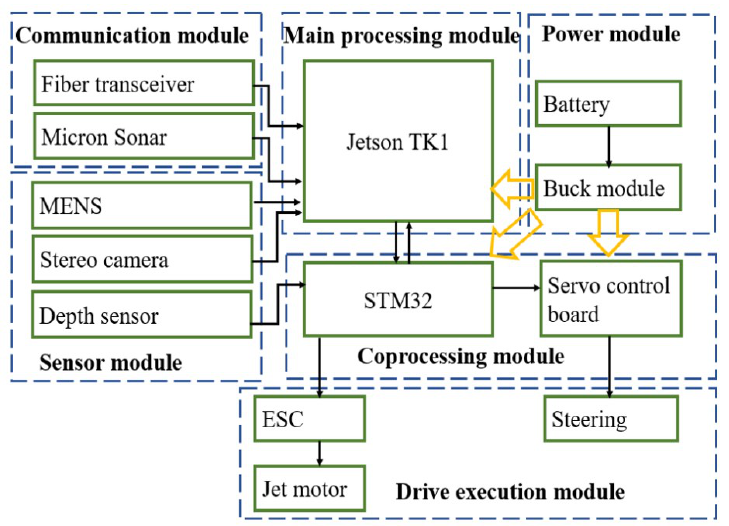
Figure 2. Electrical devices and modules of the new-generation spherical robot